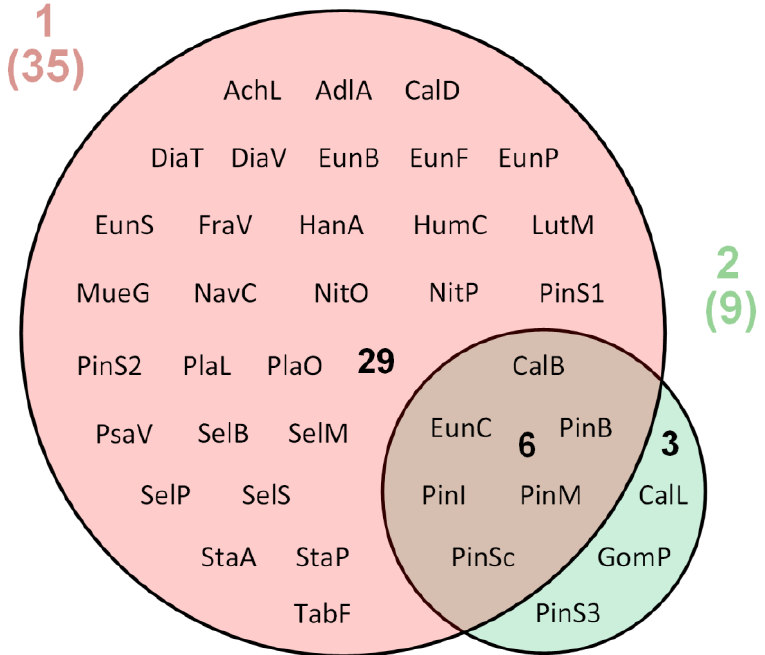
Figure 4. The similarities between diatom communities from the volcano soil studied. 1 (pink circle)—Mutnovsky volcano soil community, 2 (green circle)—Gorely volcano soil community. Numbers in brackets indicates the numbers of species in communities. Species abbreviations: AchL—